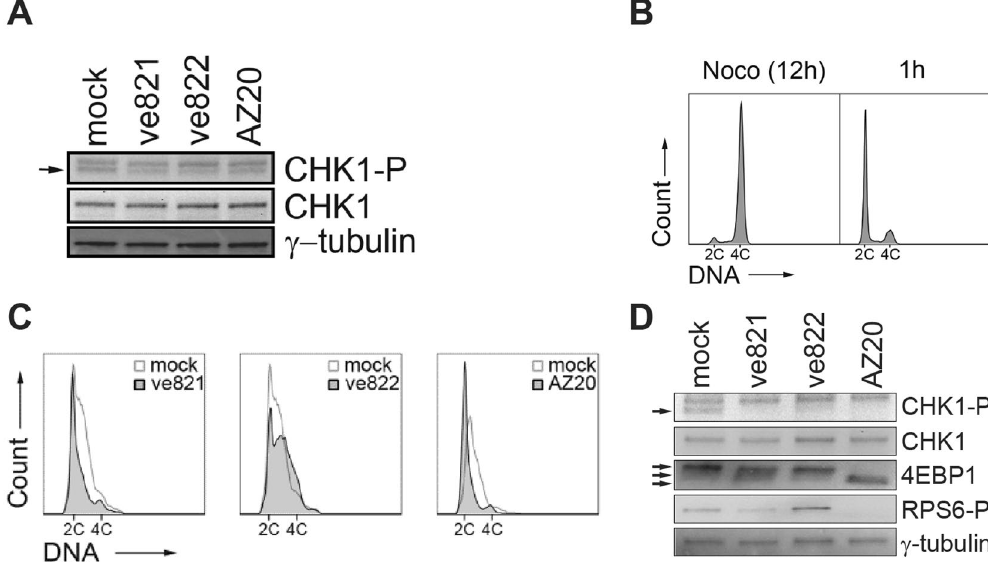
Figure 2. Three ATR inhibitors differently affect cell-cycle progression. ( A ) Immunoblot showing the presence of CHK1-P (S345) in total cell extracts of U2OS cells treated with ATRi’s ve821(10 µ M), ve822 (160 nM) or AZ20 (3 µ M) for 1 hour. Total CHK1 levels are shown for comparison and γ -tubulin is shown as loading control. Full-length blots are presented in Supplementary Fig. S2. ( B ) DNA histograms of U2OS cells synchronized in mitosis (nocodazole and shake off, left), released into the cell cycle and incubated for 1 h (right). ( C ) DNA histograms of U2OS cells synchronized in mitosis, released into the cell cycle and incubated with different ATRi’s (10 μ M ve821, 160 nM ve822, 3 μ M AZ20) and mock (DMSO) from 1 hour after release, samples were taken 11 h after release. DNA staining and flow cytometry analysis of the ATRi-treated samples were performed using barcoding, each set contained a mock-treated sample for normalization. ( D ) Immunoblot showing the presence of CHK1-P (S345), RPS6-P and 4EBP1 in total cell extracts of U2OS cells treated with ATR inhibitors ve821 (10 μ M), ve822 (160 nM) or AZ20 (3 μ M). The inhibitors were added 1 h after release from nocodazole arrest and shake off, for a duration of 4 h. Arrows point to several 4EBP1 bands. Total CHK1 levels are shown for comparison and γ -tubulin is shown as loading control. Full-length blots are presented in Supplementary Fig.